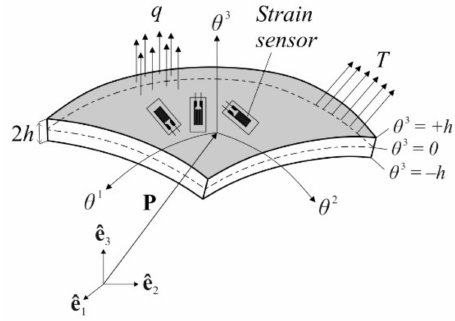
Figure 1. Notation for the curved shell